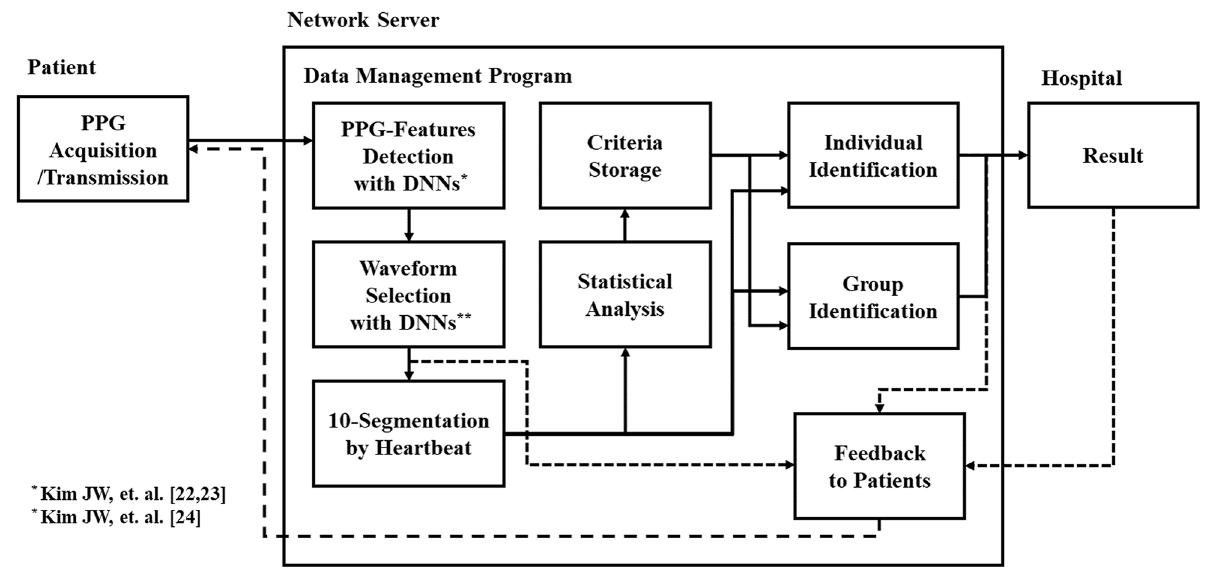
Figure 5. Block diagram of the PPG waveform analysis system, which incorporates DNN models for individual identification and group